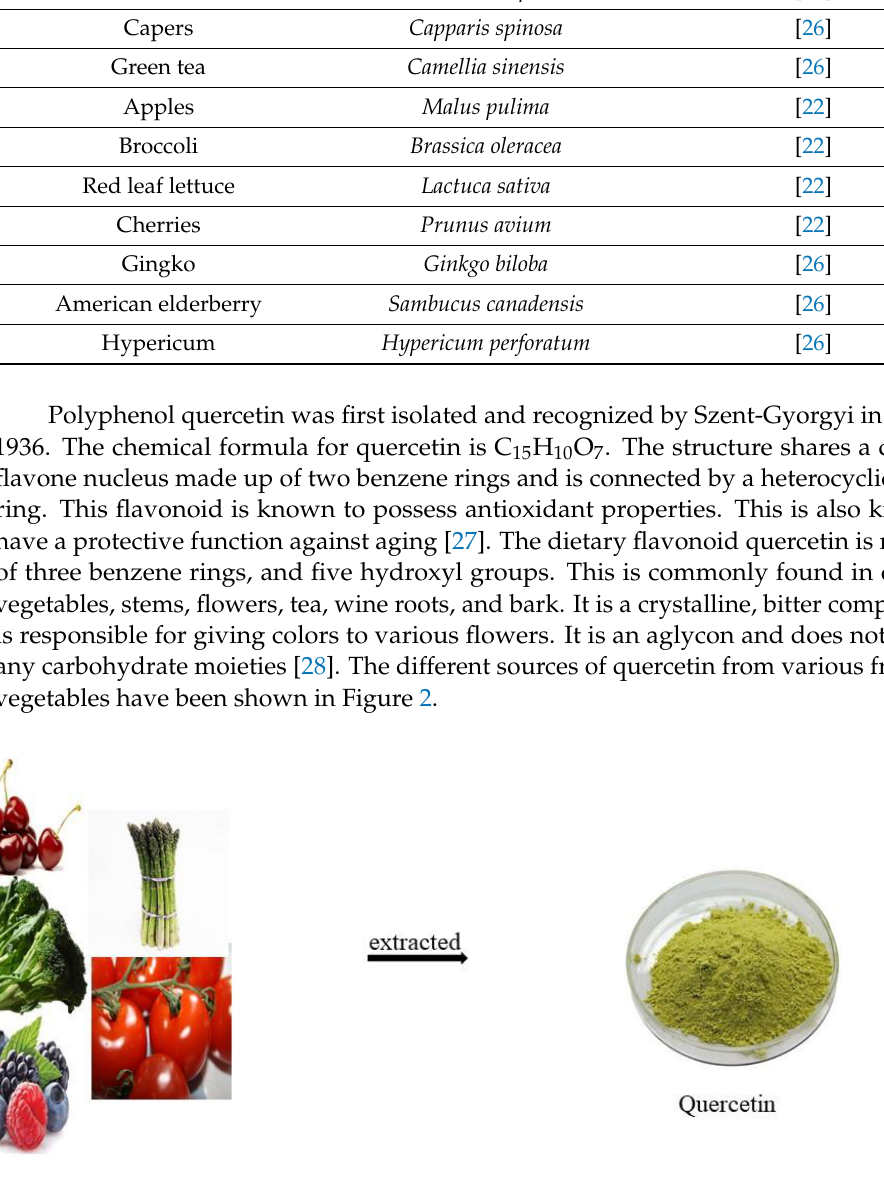
Figure 2. Quercetin from different fruits and vegetables.